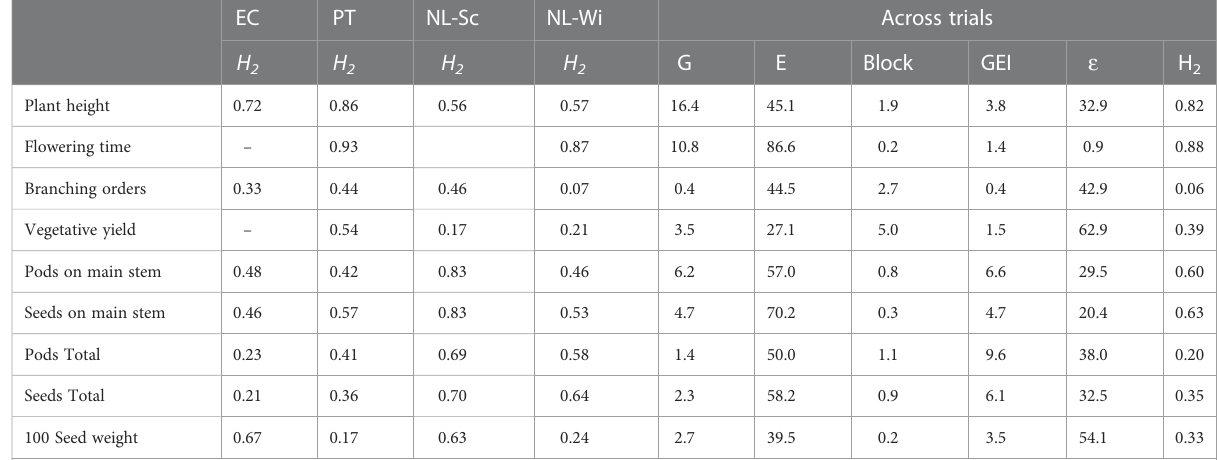
TABLE 1 Estimates of heritability (H 2 ) of breeding traits in single locations (from Gulisano et al., 2022a) and across